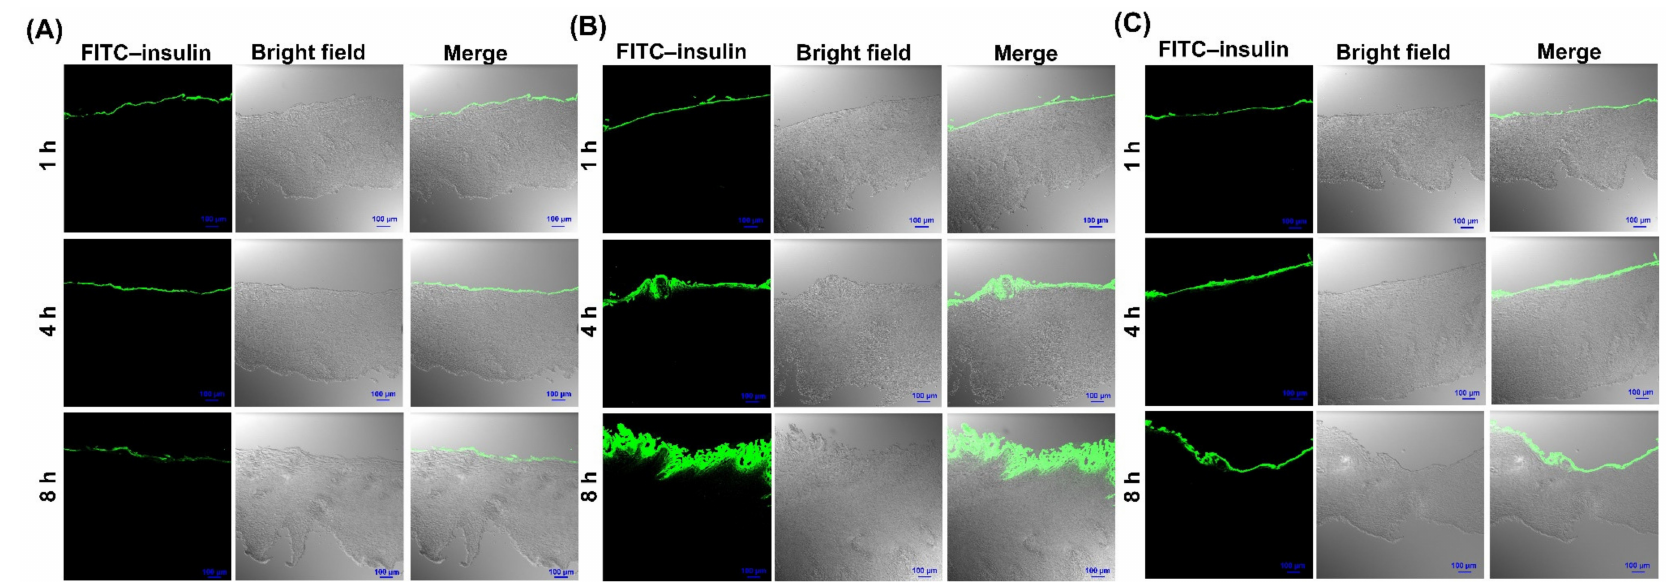
Figure 6. CLSM assessment of the porcine buccal tissues after the application of the ( A ) FITC–insulin solution and FITC–insulin-loaded elastic liposomes (( B ) SGDC-EL and ( C ) SC-EL) at predetermined time points (1, 4, and 8 h). The scale bar and magnification were 100 µ m and × 10,